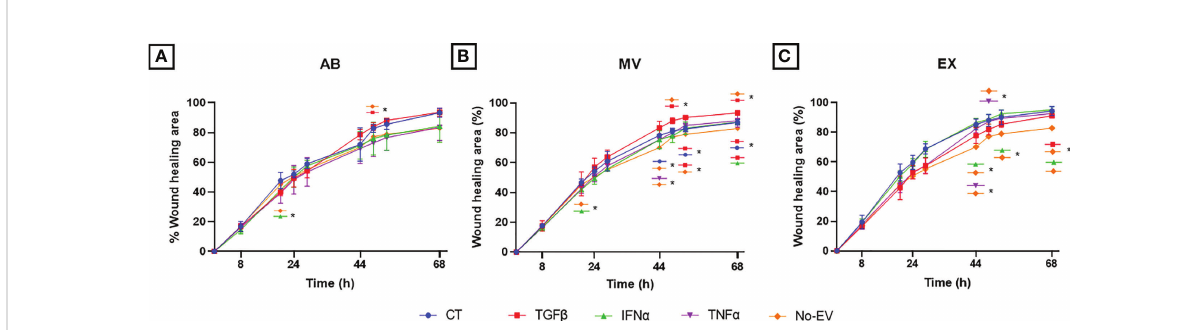
FIGURE 5 Priming UCMSCs with cytokines differentially affected the capacity of derived EVs to stimulate chondrocyte migration. Chondrocyte migration was analyzed using a wound-scratch assay under the treatment of (A) UCMSC-ABs (B) UCMSC-MVs; (C) UCMSC-EXs. TGF b -EVs induced chondrocyte migration signi fi cantly at latter experimental time points. CT-AB/MV/EX: chondrocytes treated with AB/MV/EX secreted from non- priming UCMSCs; TGF b -AB/MV/EX: chondrocytes treated with AB/MV/EX secreted from TGF b -primed UCMSCs; IFN a -AB/MV/EX: chondrocytes treated with AB/MV/EX secreted from IFN a -primed UCMSCs; TNF a -AB/MV/EX: chondrocytes treated with AB/MV/EX secreted from TNF a - primed UCMSCs; No-EV: chondrocytes cultured in DMEM/F12 5% EV-depleted FBS and no EV addition. The images were captured at different time points in which chondrocytes migrated by time to close the wound and analyzed using ImageJ. Data are presented as the mean percent area of wound coverage in m m 2 ± SD (n = 3). Statistical signi fi cance was determined by Two-Way ANOVA and indicated by: * where p < 0.05. Error bars indicate ±